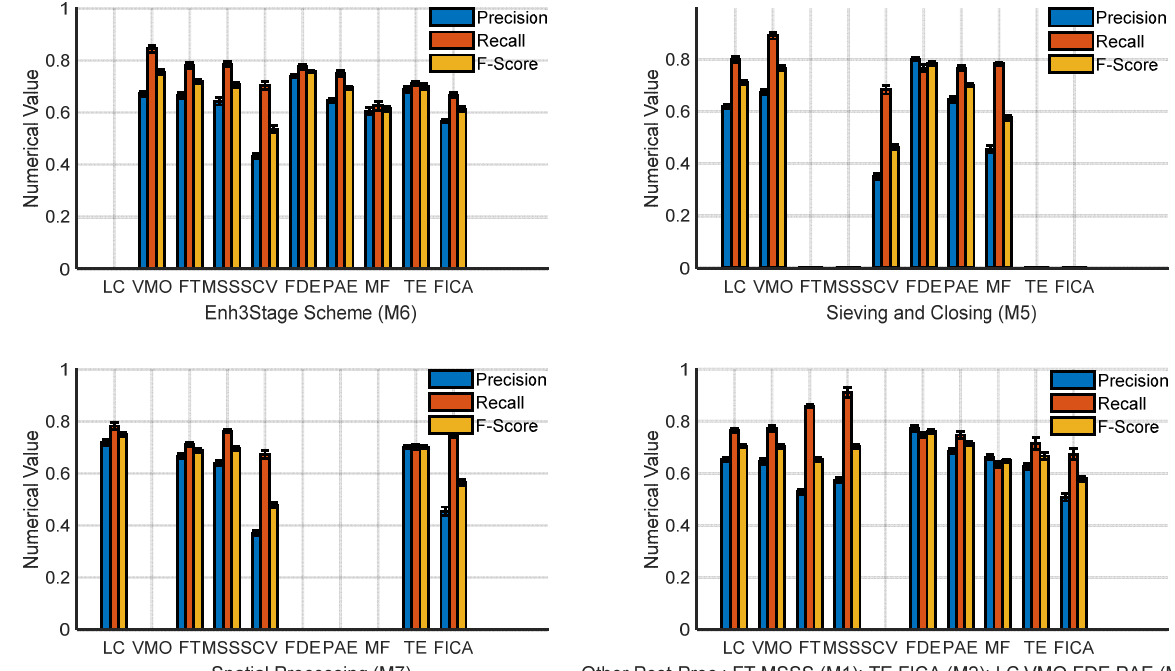
Figure 3. Precision, Recall and F ‐ score for ten feature extraction ‐ based algorithms each combined with their best three post ‐ processing schemes.